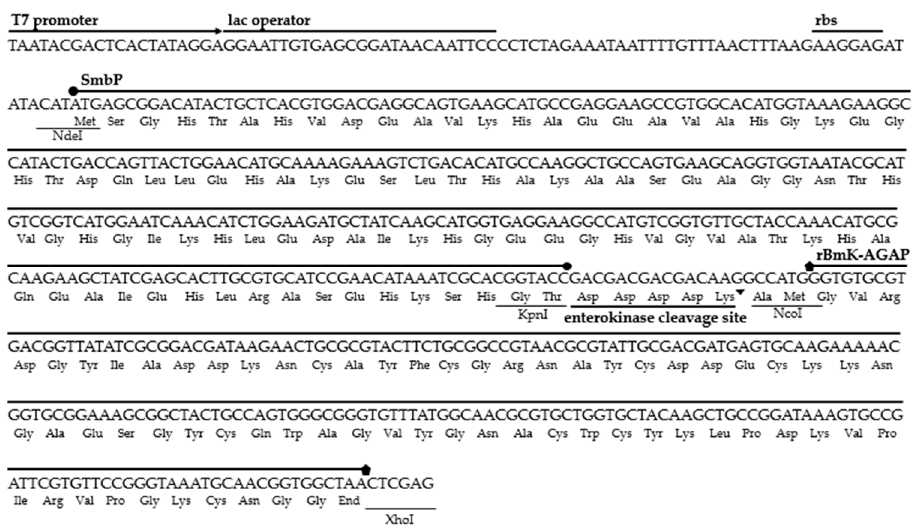
Figure 1. DNA and amino acid sequences for the construct pET30a(+)_SmbP_BmK-AGAP. For small-scale expression experiments, transformed E. coli SHuffle cells were in- cubated overnight at 25 ◦ C after induction with 1 mM IPTG. Cell lysates from